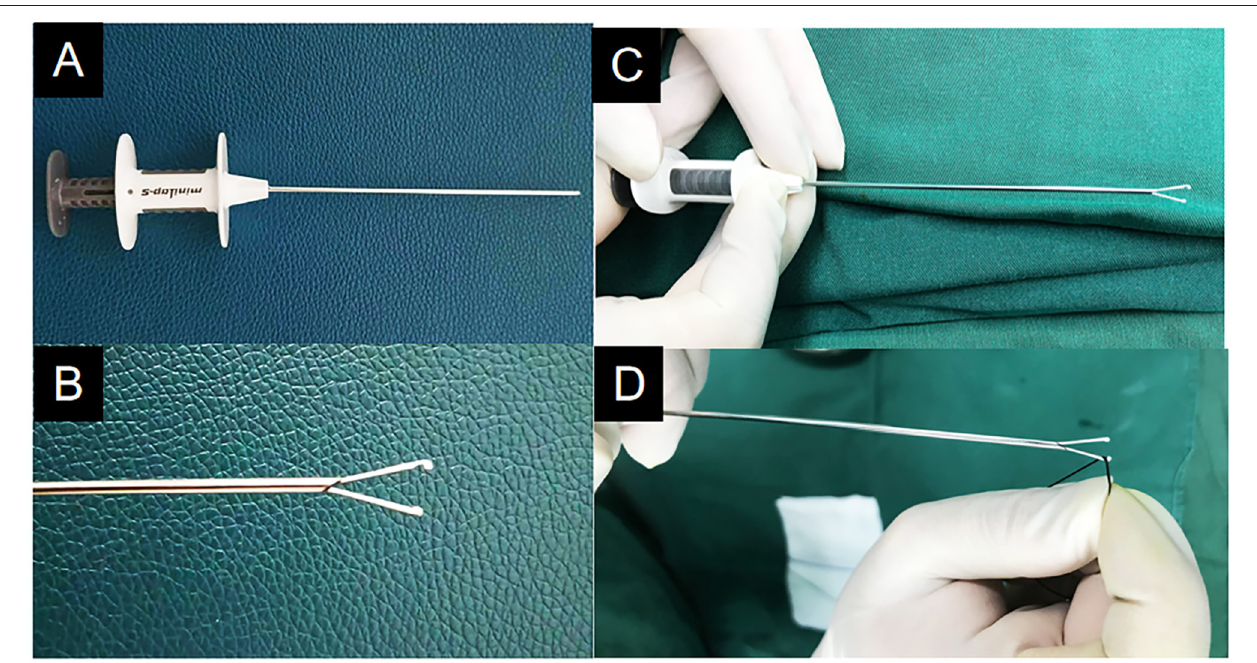
FIGURE 1 | The abdominal wall suture device with water injection function. (A) The appearance image. (B) The front end of the injection needle core is two retractable concave arc-shaped metal hooks. (C) Pressing the end of the abdominal wall suture device can open the claw of the needle. (D) A spring is installed in the sheath of the hand-held part of the back end, which is convenient for the operator to pull out the needle core and hook the ligation line at the front end of the needle core, and then it can automatically spring back to insert and